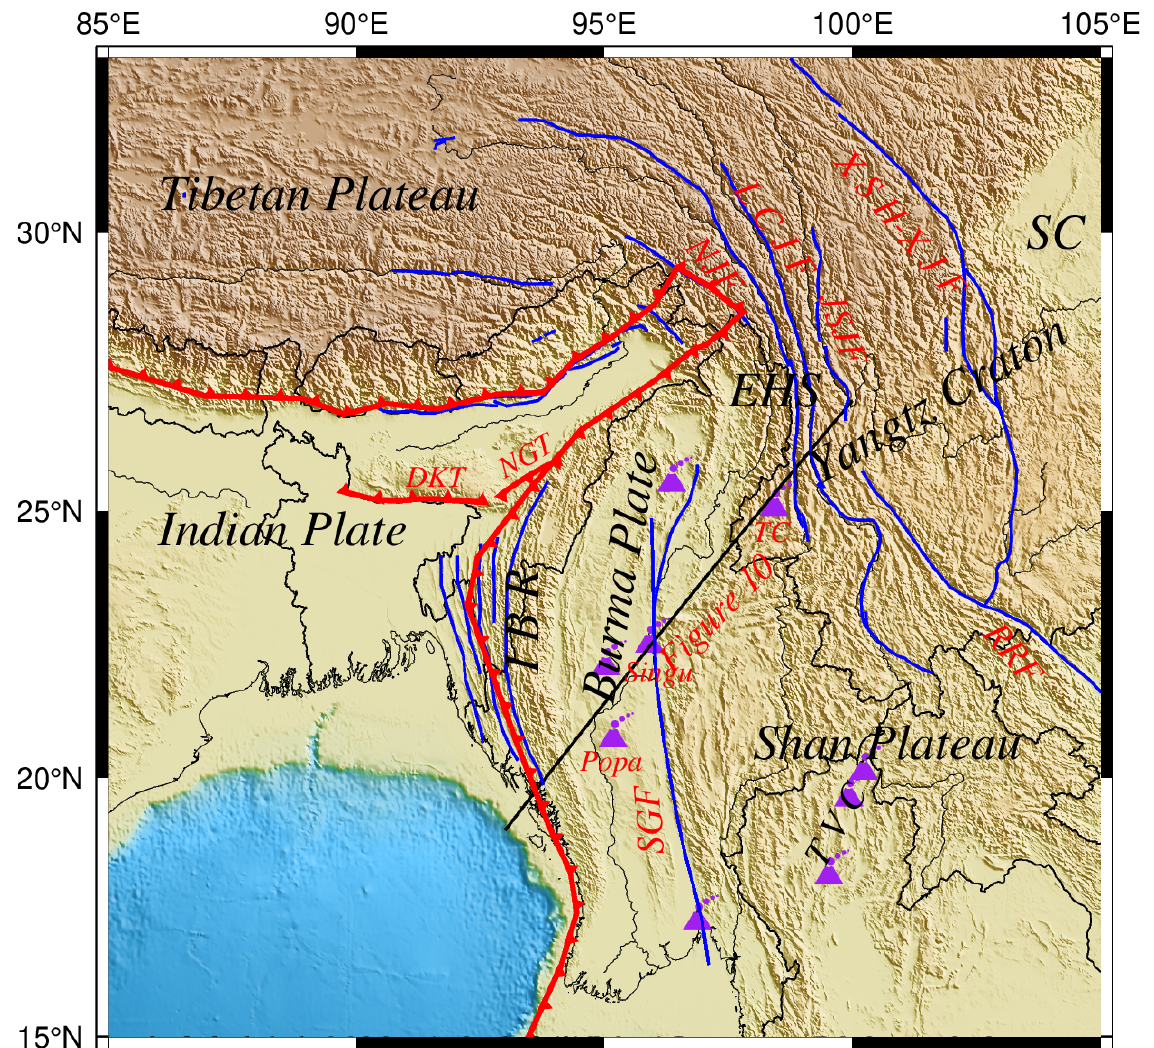
Figure 1. An overview map of Myanmar and surrounding areas. The main fault and plate boundaries are modified by China-geospatial data (https://github.com/gmt-china/china-geospatial-data/releases (accessed on 15 April 2021)), the location of the volcano was revised by the 2013 Global Volcanic Activity Plan (https://volcano.si.edu (accessed on 15 April 2021)) and the volcano discovery (https://www.volcanodiscovery.com (accessed on 15 April 2021)). (DKT: Dauki Thrust; EHS: Eastern Himalayan Syntaxis; IBR: Indo–Burma Ranges; JSJF: JinShaJiang Fault; SC: Sichuan Block; LCJF: LangCangJiang Fault; NGT: Naga Thrust; NJF: NuJiang Fault; RRF: Red River Fault; SGF: Sagaing Fault; TC: Tengchong Volcano; TVC: Thai volcanic cluster; XSH-XJF: XiangShuiHe–XiaoJiang Fault).